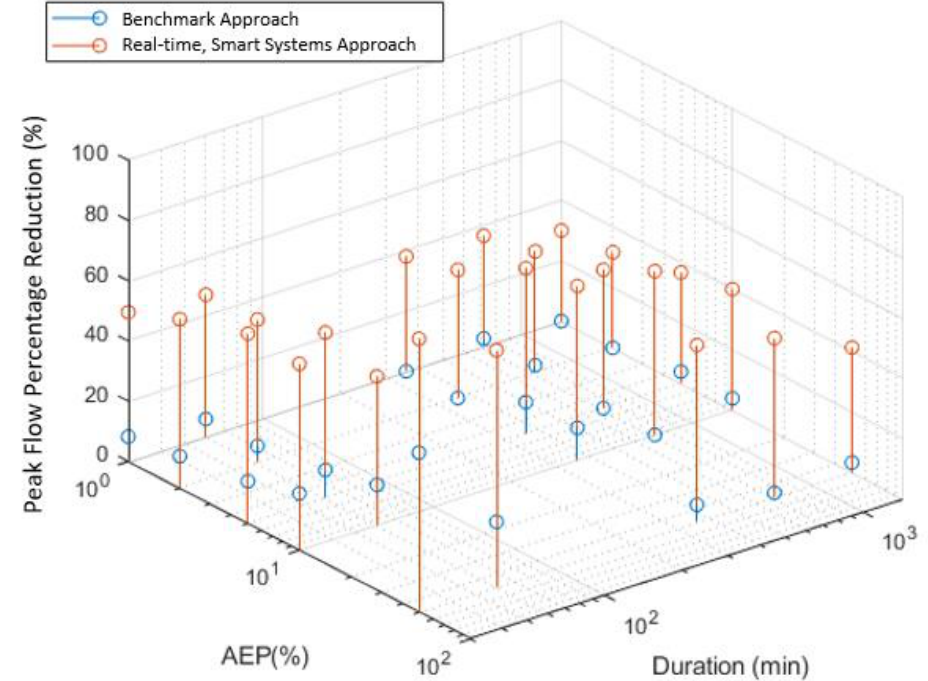
Figure 5. Percentage peak flow reduction of benchmark tanks and real-time smart tank systems for a range of durations and AEPs with 2 × 2 m 3 tanks for Adelaide.